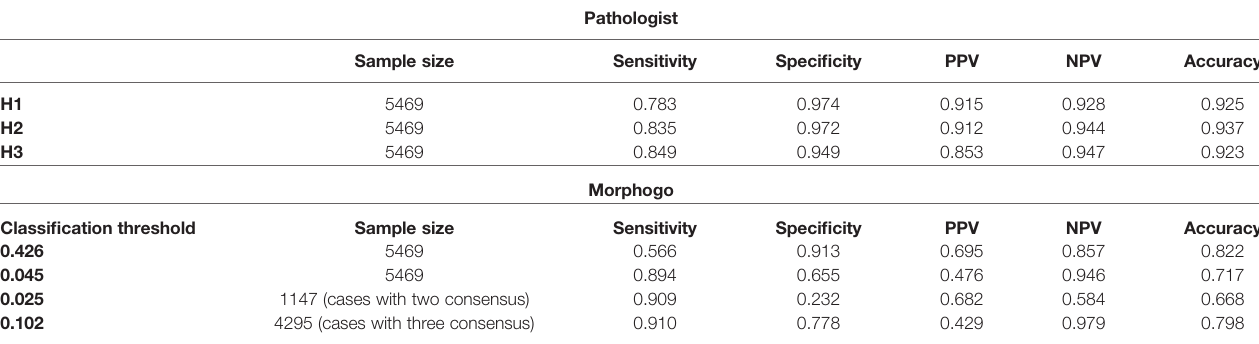
TABLE 1 | The sensitivity, speci fi city, positive predictive value, negative predictive value of Morphogo and pathologist H1, H2 and